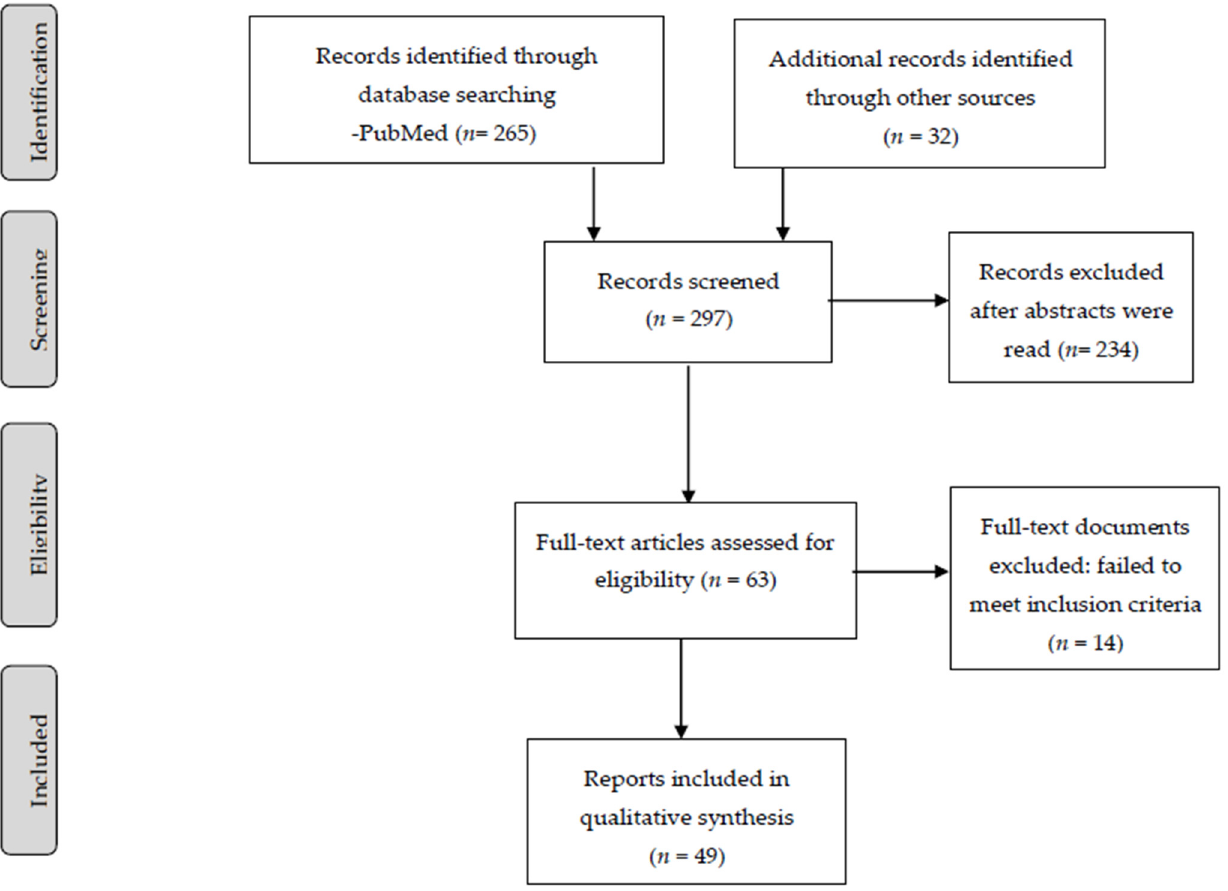
Figure 1. Flow diagram of included reports.